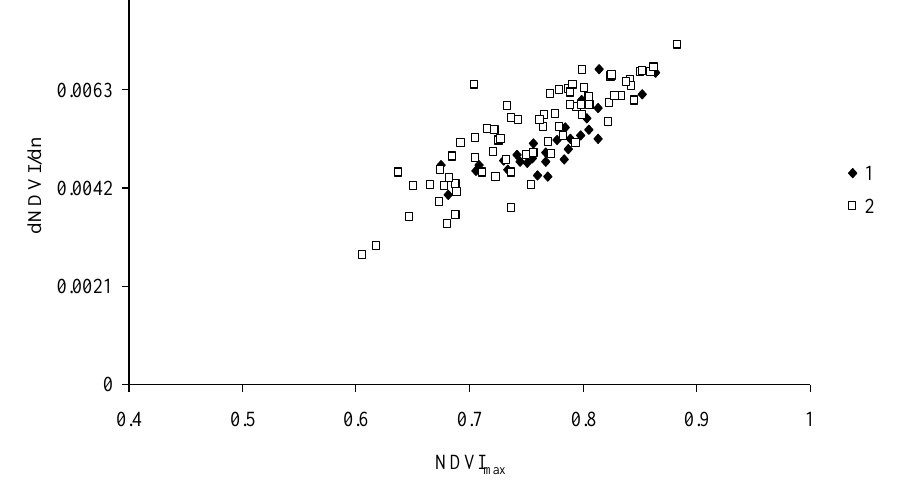
Figure 6. NDVIF max and dNDVIF / dn for forest communities in the Krasnoyarsk Territory ( 1 ) and Khakassia ( 2 ) for 2003–2017.